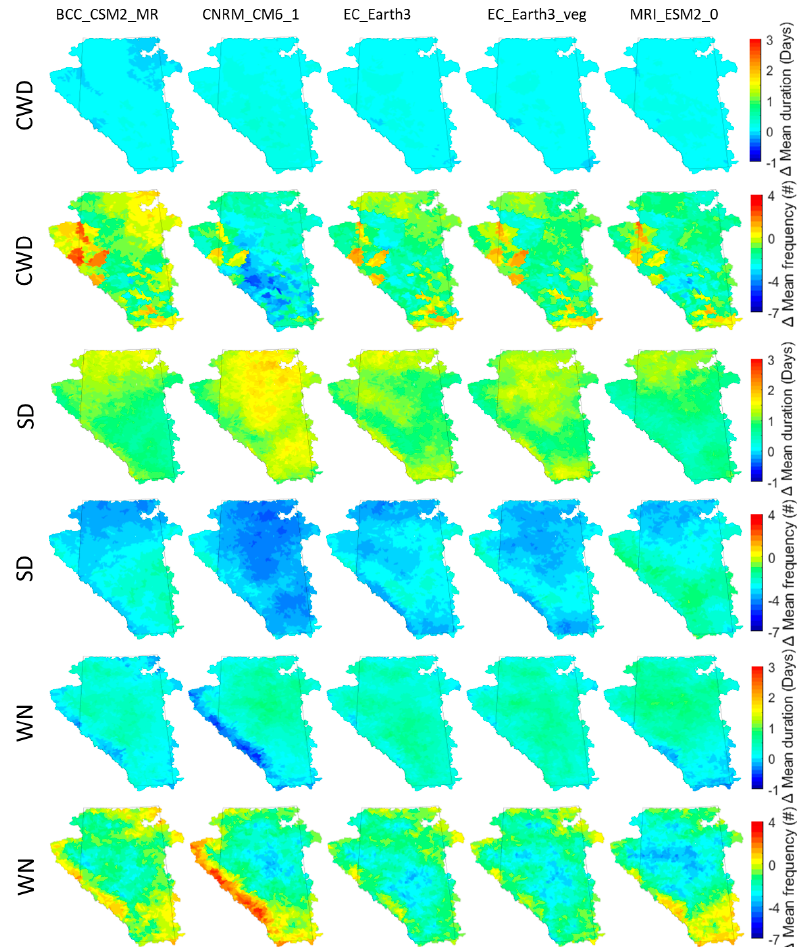
Figure 12. Spatial distribution of delta (difference between downscaled GCM simulations and observation) mean annual duration and frequency of CWD, SD, and WN for the 1983–2014 period for 2255 sub-basins. A positive delta mean frequency and duration indicate an overestimation by downscaled GCMs.